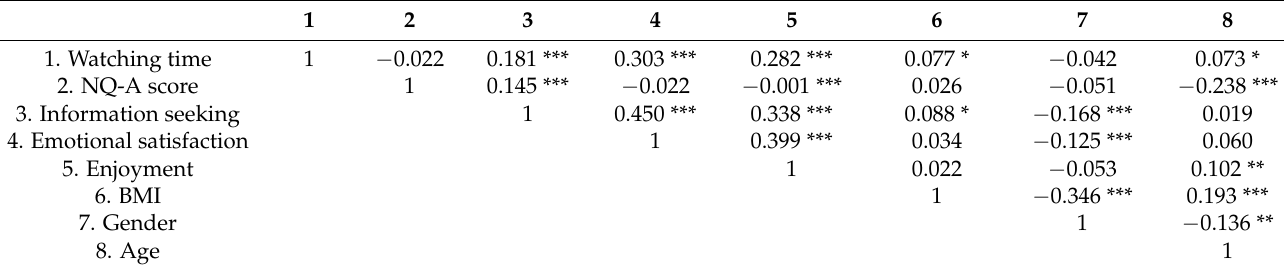
Table 3. Pearson’s correlation matrix of the variables of